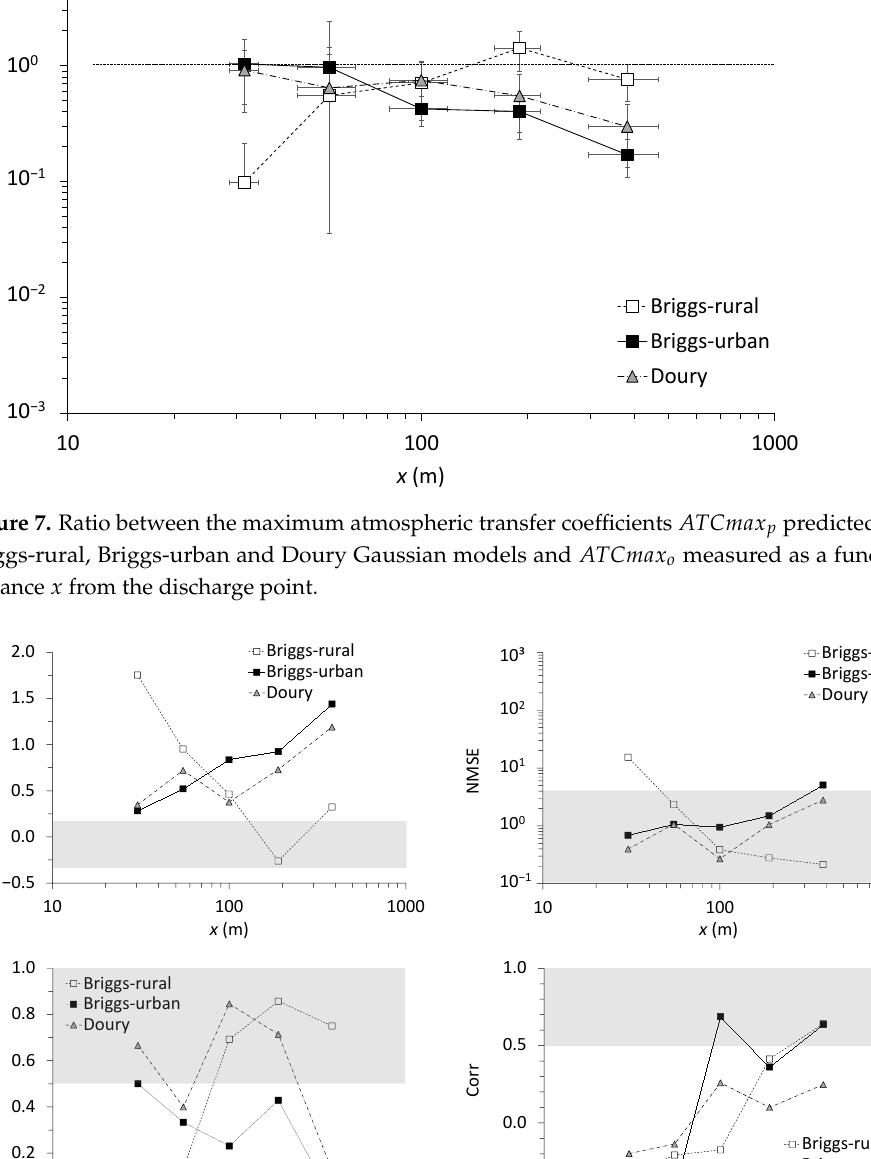
Figure 8. Evaluation criteria 𝐹𝐵 , 𝑁𝑀𝑆𝐸 , 𝐹𝐴𝐶2 and 𝐶𝑜𝑟𝑟 for Briggs-rural, Briggs-urban and Doury Gaussian models when predicting the maximum atmospheric transfer coefficients measured 𝐶𝑇𝐴𝑚𝑎𝑥 o as a function of distance x from the discharge point; the acceptability zone for each criterion is shown in grey.